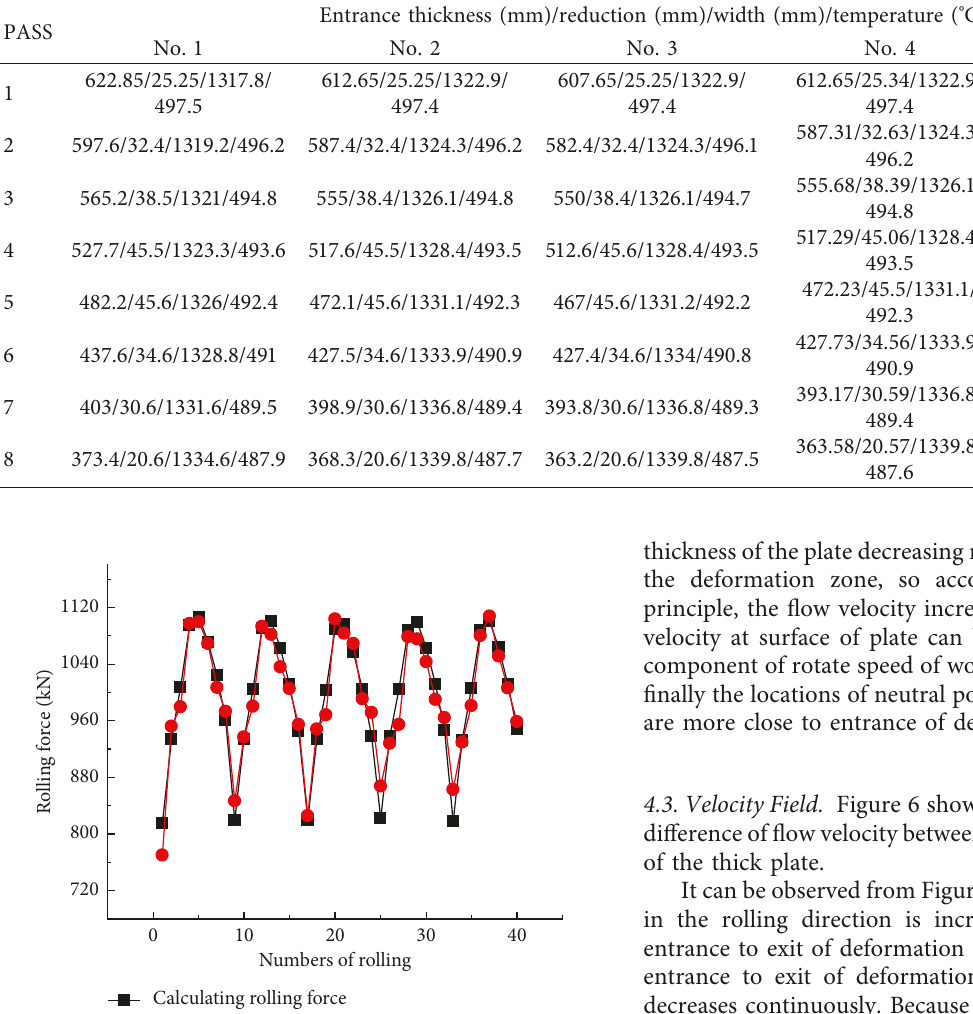
Table 1: Rolling parameters applied in the comparison of experiments and metal flow model.